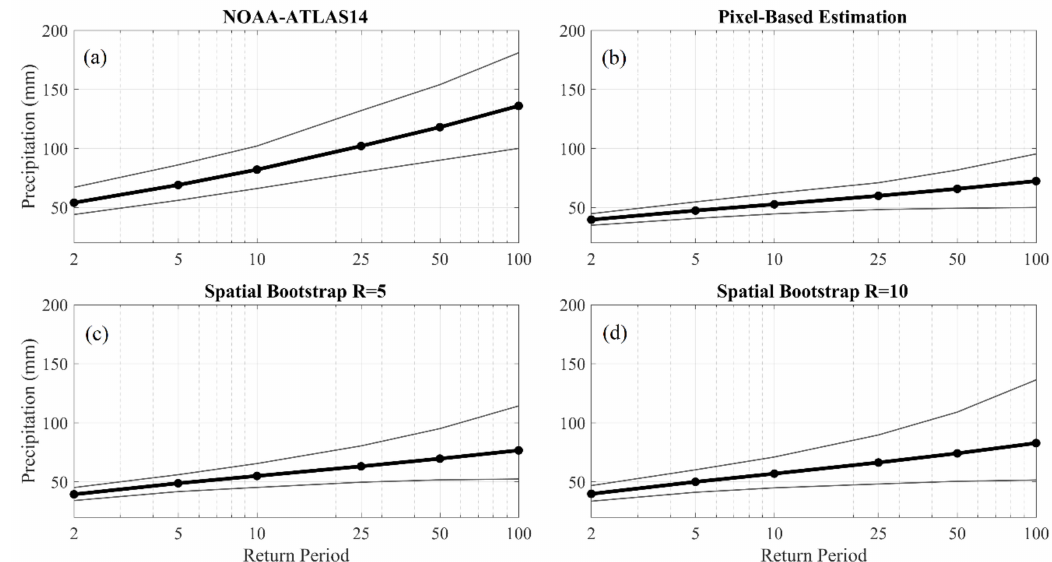
Figure 9. Precipitation Frequency Estimates (PFE) and (95–5%) confidence limits at the location of Gauge (2) based on ( a ) NOAA-Atlas14, ( b ) pixel-based approach, and ( c , d ) regional spatial bootstrap with a region of R = 5 pixels ( c ) and R = 10 pixels ( d ).